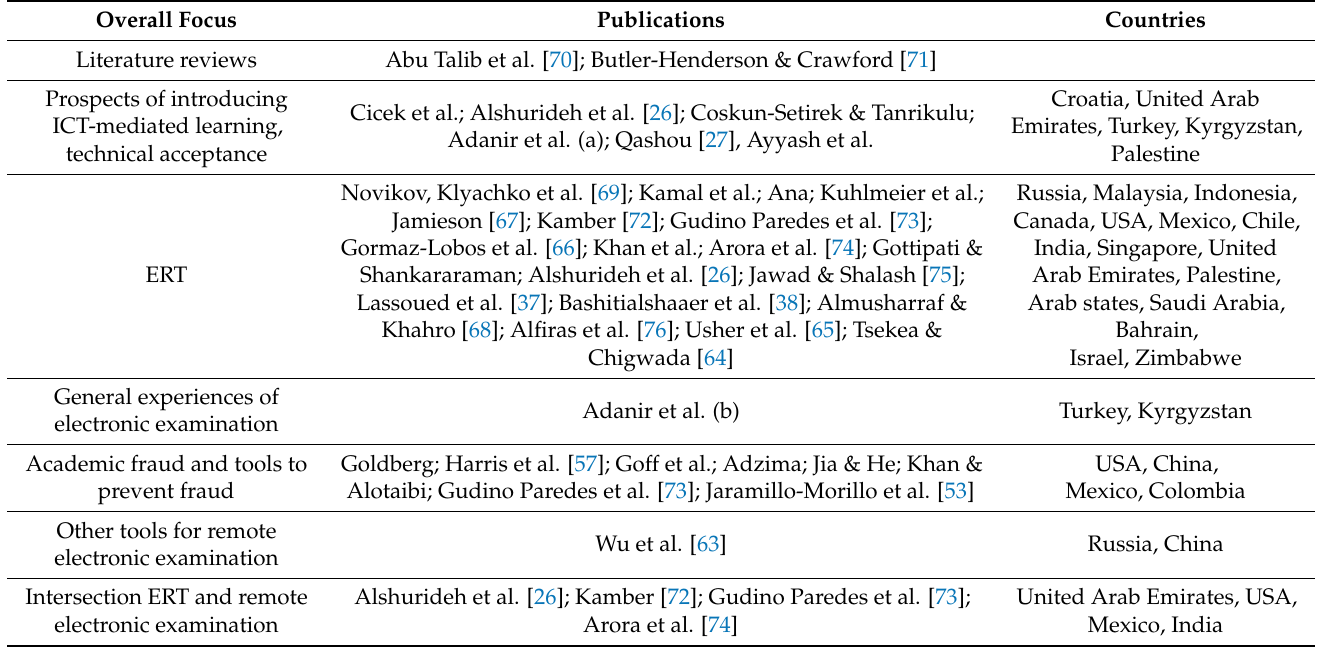
Table 1. Summary of Scopus search results. (See Scopus listed publications in Appendix